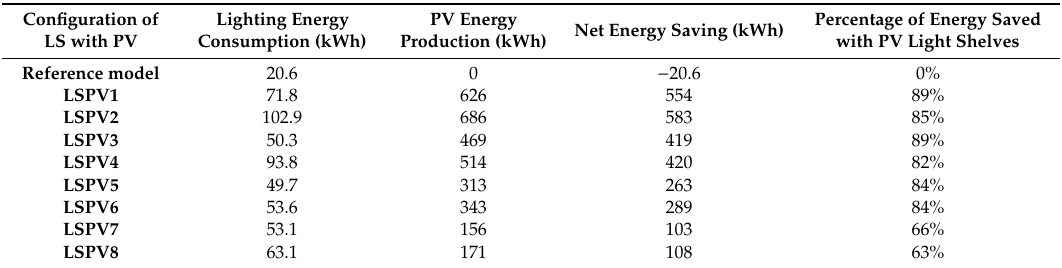
Table 11. The yearly lighting energy consumption of various light shelf configurations compared to the base